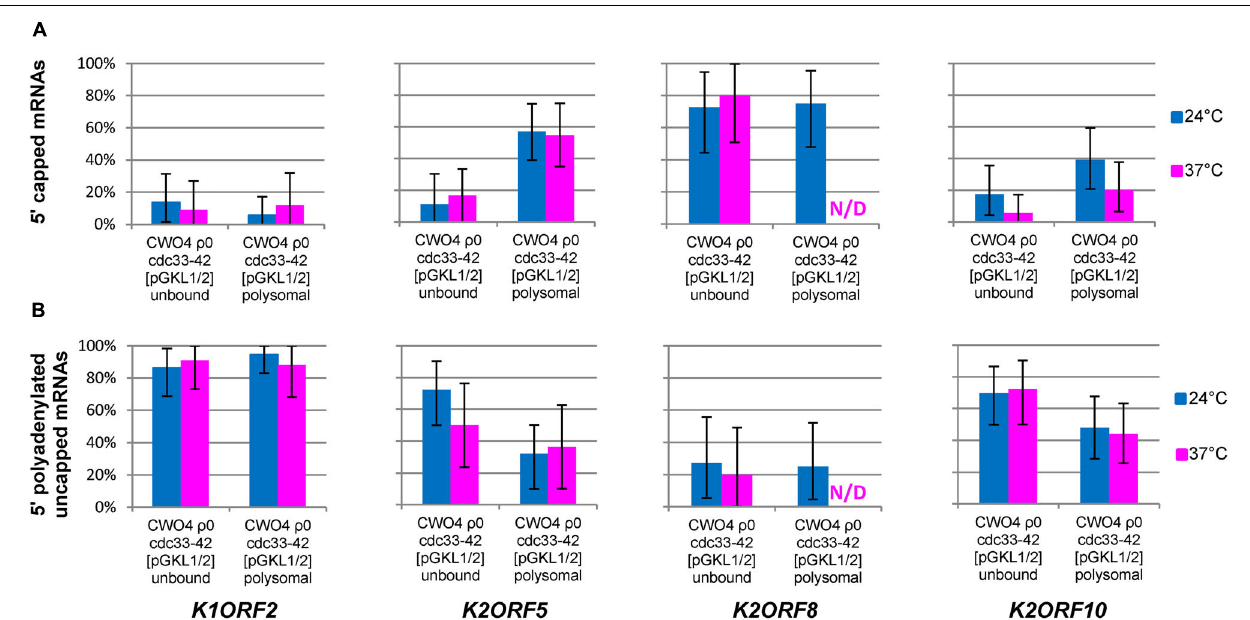
FIGURE 12 | 5 (cid:48) polyadenylated and uncapped mRNAs associate with high polysomal fractions independently of cap-binding eIF4E. Bar plots depict the results of the 5 (cid:48) RACE analyses of K1ORF2 , K2ORF5 , K2ORF8 , and K2ORF10 mRNAs from non-polysomal (unbound) and polysomal fractions of the S. cerevisiae CWO4 cdc33-42 ρ 0 [pGKL1/2] strain cultured at the permissive (24 ◦ C, blue bars) and non-permissive (37 ◦ C, magenta bars) temperatures. The cap-binding translation initiation factor eIF4E was not functional at the non-permissive temperature ( Figure 11 ). (A) Proportions of 5 (cid:48) capped mRNAs [in %] outside the polysomes (unbound) and in the high polysomal fraction (polysomal); (B) proportion of 5 (cid:48) polyadenylated (and uncapped) mRNAs [in %] outside the polysomes (unbound) and in the high polysomal fraction (polysomal). Error bars depict the 95% confidence intervals calculated using the adjusted Wald method.